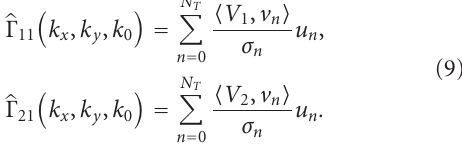
= f = ( f x ,0, f z ), Γ 11 is the S R